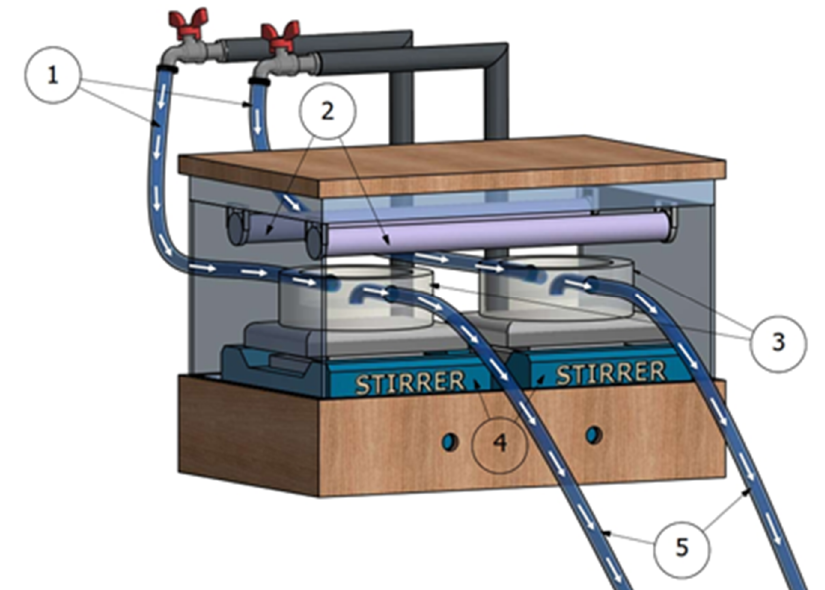
Figure 2. Diagram of the photoreactor used in the degradation of the DB1 dye. (1) Water inlet, (2) UV lamps, (3) Samples, (4) Magnetic stirrers, (5) Water outlet.